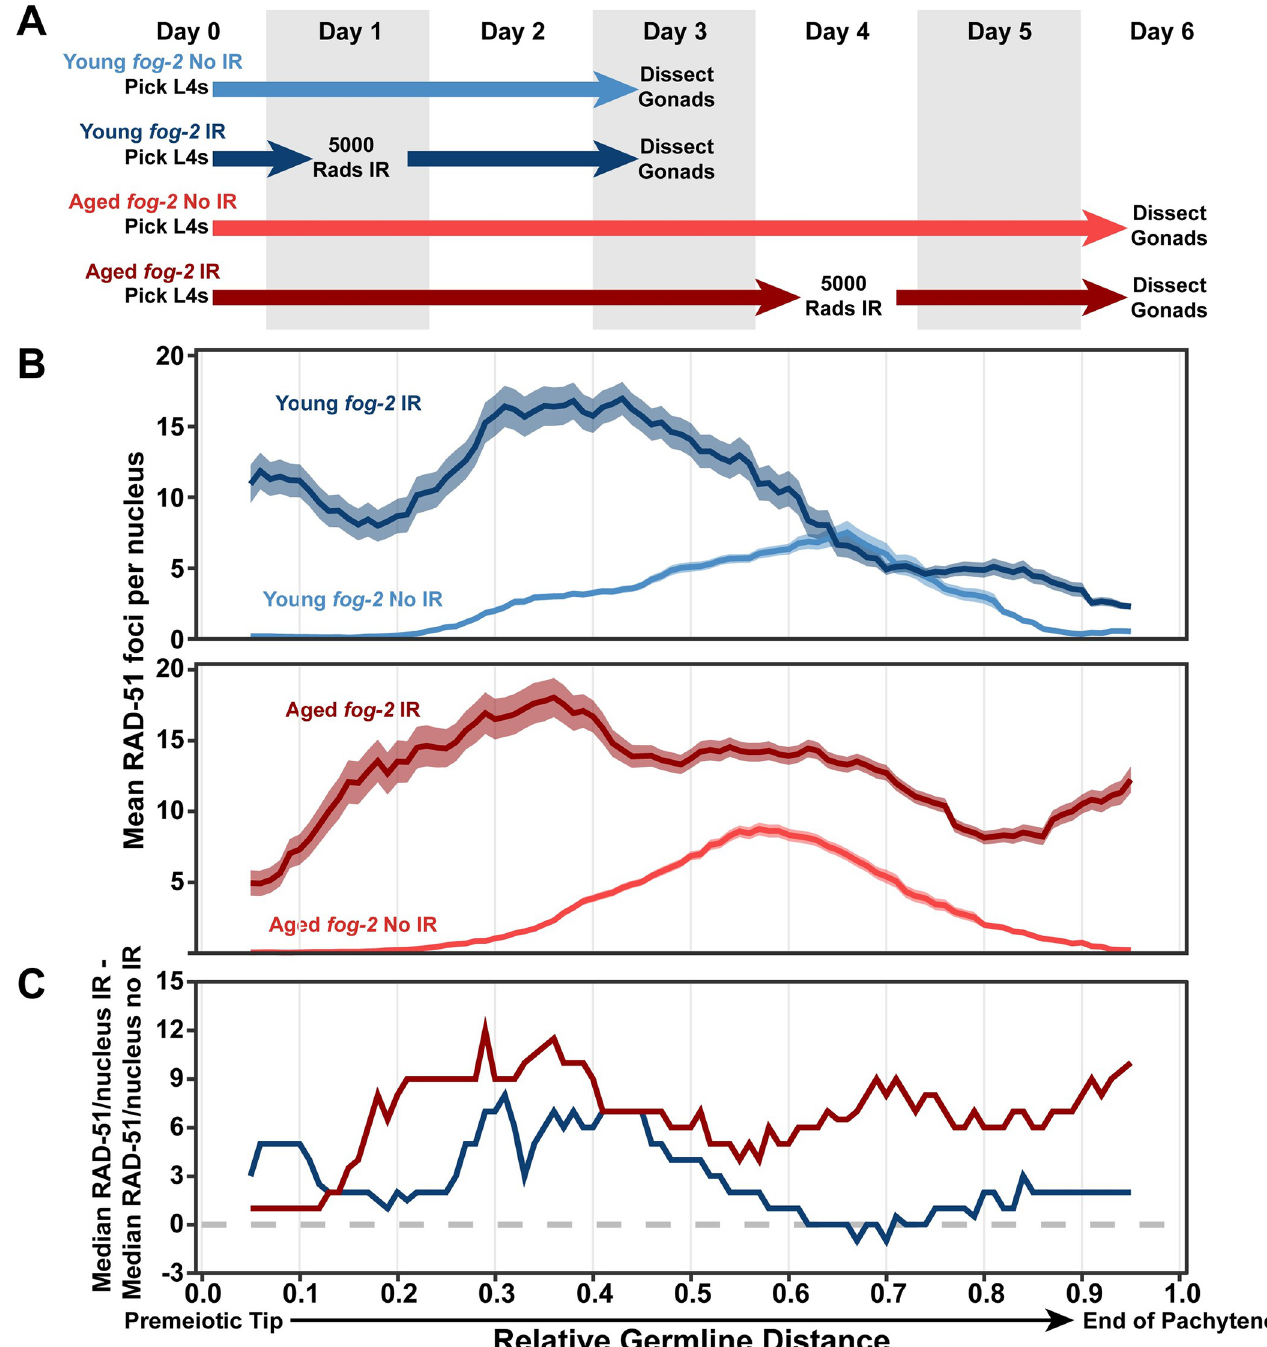
Fig 3. DNA double strand break repair is disrupted in aged fog-2 feminized germlines. A) Schemes used to isolate young and aged fog-2(q71) worms for experiments. Note that ‘young’ worms are 3 days post-L4 and ‘aged’ worms are 6 days post-L4 at the time of dissection in this Fig. Days count ~18–24 hour periods after hermaphrodites were isolated as L4 larvae and are separated by alternating grey shaded boxes. Irradiated (IR) germlines were exposed to ionizing radiation at the first or fourth day of adulthood and were allowed to recover for two days before analysis (see Methods). Unirradiated germlines (No IR) were never exposed to radiation. B) RAD-51 foci per nucleus in irradiated (IR) and unirradiated (no IR) oocytes. Line plots represents the mean RAD-51 foci per nucleus along the length of the germline in a sliding window encompassing 0.1 units of normalized germline distance with a step size of 0.01 germline distance units. Plots in panel B share an X axis with the plot in panel C. Mean RAD-51 foci were calculated from nuclei analyzed in n = 9 total germlines derived from � 3 experimental replicates within each age group. Shaded areas around each line represent ± SEM. Average nuclei quantified in each bin ± standard deviation: Young fog-2 No IR 141.6 ± 26.6, Young fog-2 IR 134.4 ± 27.9, Old fog-2 No IR 148.5 ± 29.6, Old fog-2 IR 142.4 ± 30. Germline distance was normalized to the